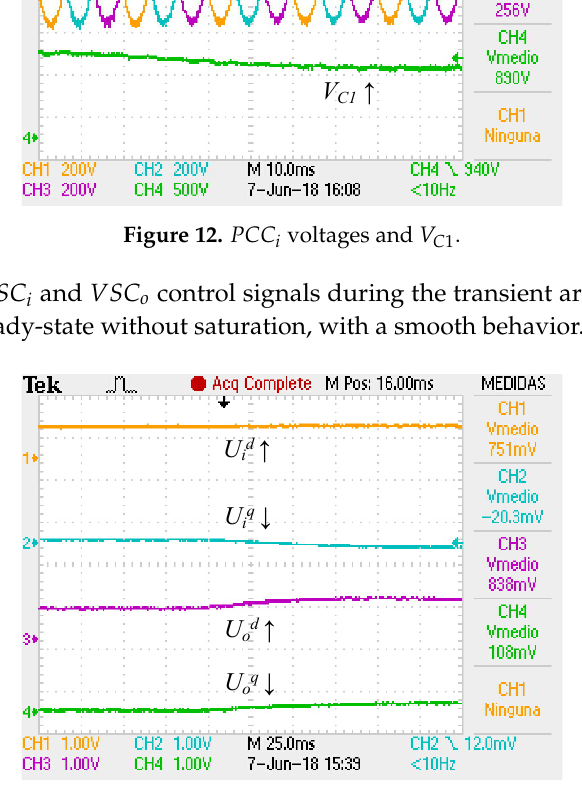
Figure 13. VSC i and VSC o control signals.